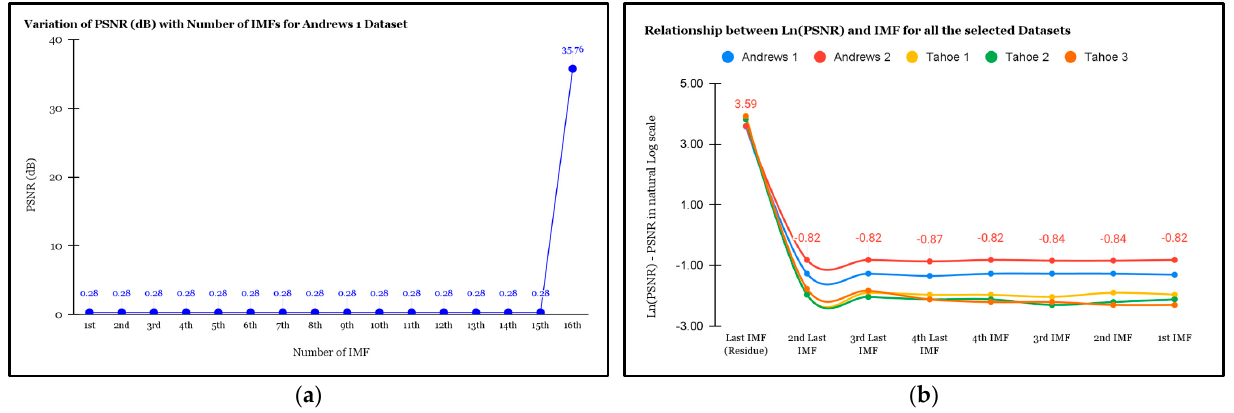
Figure 6. ( a ) Variation in PSNR (dB) with the corresponding IMFs for the Andrews 1 dataset. ( b ) Relationship between PSNR in natural Log (Ln) scale and IMF for all the selected datasets.